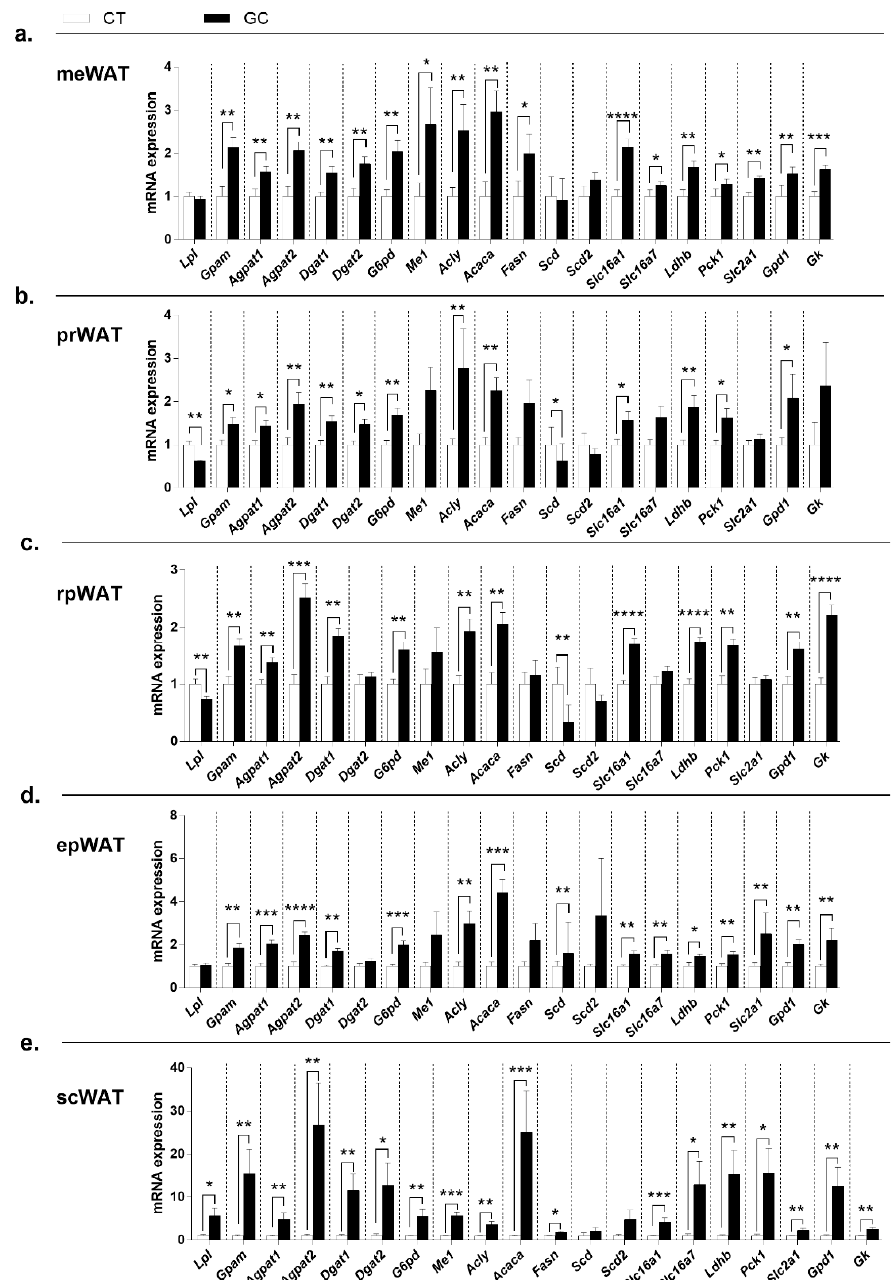
Figure 6. Gene expression of the lipogenic pathway in white adipose tissue. ( a ) mesenteric—meWAT; ( b ) perirenal—prWAT; ( c ) retroperitoneal—rpWAT; ( d ) epididymal—epWAT; and ( e ) sub- cutaneous inguinal. Genes of lipoprotein lipase— Lpl ; enzymes of fatty acids esterification— Gpam, Agpat1, Agpat2, Dgat1, and Dgat2 ; cytosolic NADPH recyclers— G6pd and Me1 ; enzymes of lipogenesis de novo— Acly, Acaca , and Fasn; fatty acid desaturases— Scd and Scd2 ; monocarboxylate transporters— Slc16a1 and Slc16a7 ; lactate dehydrogenase— Ldhb ; the key enzyme of glyceroneogenesis— Pck1 ; glucose transporter 1— Slc2a1 ; the last enzyme of glycerol-3-phosphate generation glycolytic pathway and glyceroneogenesis— Gpd1 ; and the glycerol kinase— Gk —of control (CT; n = 7–12), and glucocorticoid-treated (GC; n = 11–12) rats. Data are mean ± SEM. * p < 0.05; ** p < 0.01; *** p < 0.001, and **** p < 0.0001 vs. CT (unpaired Student t -test; Mann–Whitney test in ( a ) ( Gpam, G6pd, Me1, Acly, Acaca, Fasn, Scd, Scd2 and Gpd1 ), ( b ) ( Agpat1, Dgat2, G6pd, Me1, Acly, Acaca, Scd, Slc16a7, and Gk) , ( c ) ( Me1, Fasn, Scd, and Slc2a1 ), ( d ) ( Agpat2, G6pd, Acly, and Ldhb ), and ( e ) ( Lpl, Agpat2, Dgat1, Dgat2, Acaca, Scd2, Slc16a1, Slc16a7, Pck1, Slc2a1, and Gpd1